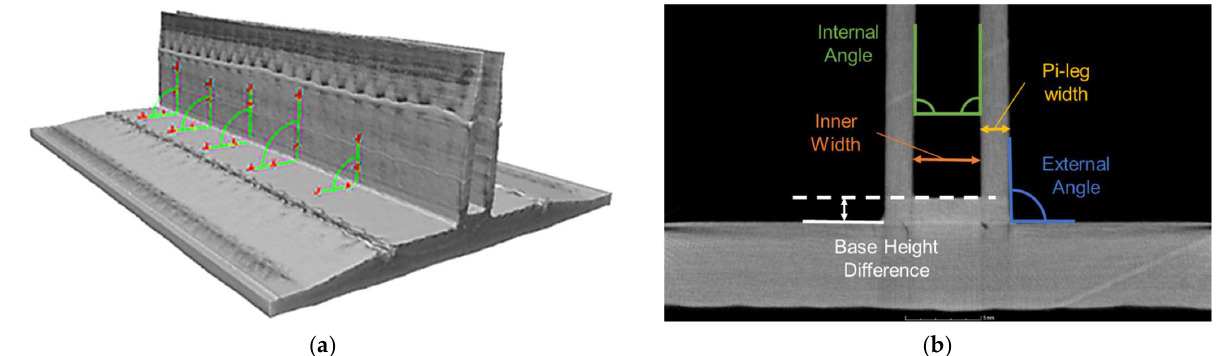
Figure 2. ( a ) 3D reconstruction of pi-NCF geometry showing five locations of cross-sectional CT measurements along the part length; ( b ) Measurements taken from each of the five CT scan cross- sections, corresponding to the results presented in Section 4.1.